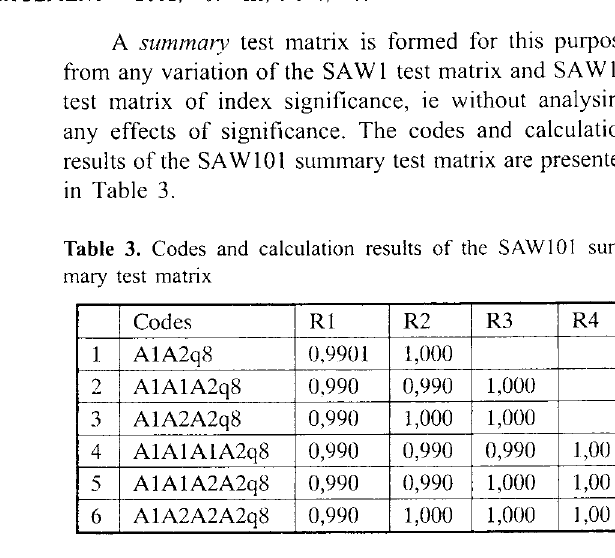
Table 1. Element values of the SAW I test